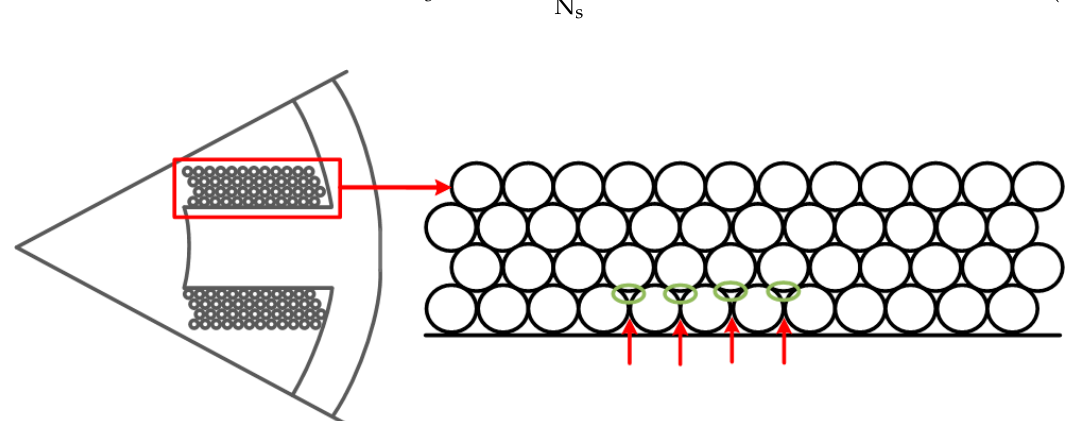
Figure 5. Space between windings.